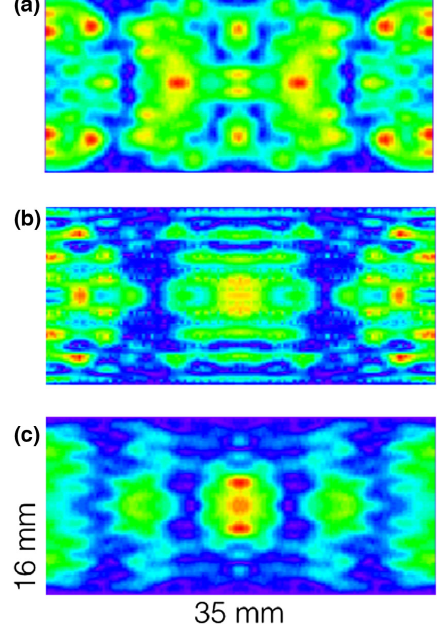
FIG. 22. Amplitude profile of the laser on output mirror without extraction hole, for